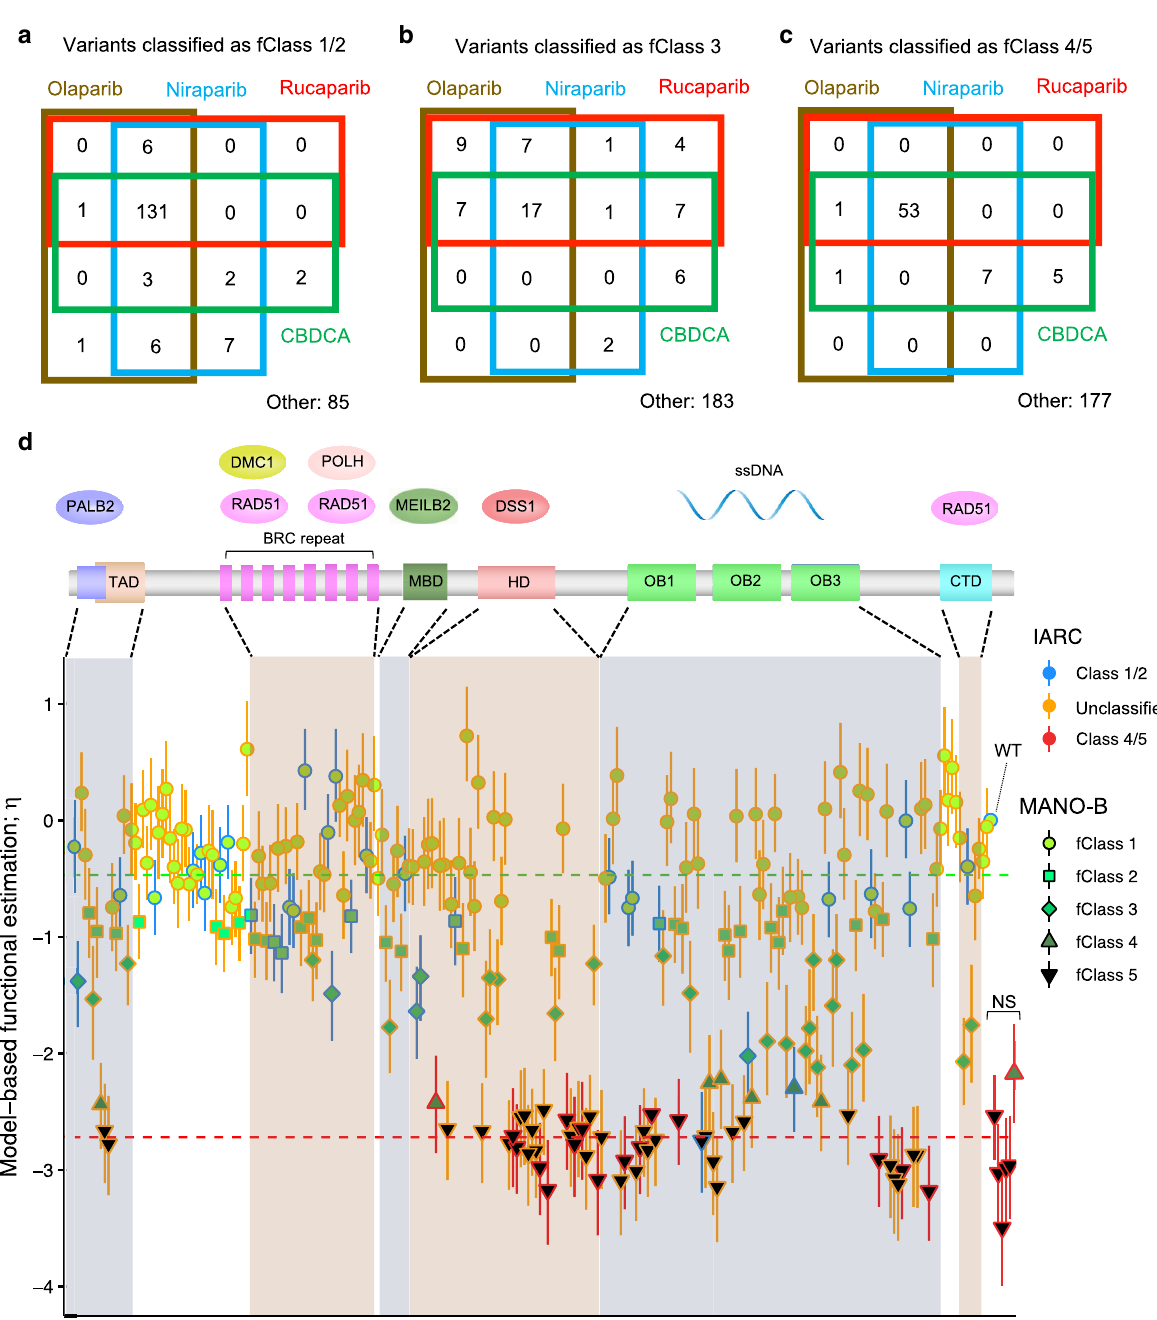
Fig. 3 Evaluation of 244 BRCA2 variants by applying Bayesian inference to the MANO-B method. a – c Functional classi fi cation by the MANO-B method with four drugs. A total of 244 BRCA2 variants were classi fi ed by Bayesian inference. The number of variants classi fi ed for each drug as fClass 1/2 ( a ), fClass 3 ( b ), and fClass 4/5 ( c ) is shown. No variant was classi fi ed as fClass 1/2 with one drug and fClass 4/5 with another drug. d Bar plots of functional variant effects and functional diagnosis of 244 BRCA2 variants mapped against the BRCA2 full-length sequence and domains. The key domains of BRCA2 consist of a PALB2 interaction domain encompassing amino acids (a.a.) 10 – 40, a transactivation domain (TAD) encompassing a.a. 18 – 105, a RAD51- binding domain including eight BRC repeats encompassing a.a. 1008 – 2082, an MEILB2-binding domain (MBD) encompassing a.a. 2117 – 2339, a DNA- binding domain encompassing a.a. 2402 – 3186 and containing a helical domain (HD) encompassing a.a. 2402 – 2669, oligonucleotide/oligosaccharide- binding domains (OBs) (OB) encompassing a.a. 2670 – 2803, 2809 – 3048, and 3056 – 3102, and a C-terminal RAD51-binding domain (CTD) encompassing a.a. 3270 – 3305. The function of each variant was estimated as a variant-speci fi c effect value, η v , based on a two-component model. Data of niraparib are shown as a representative case. The upper and lower components correspond to normal function and loss-of-function, respectively. The dotted lines indicate the median value of each component. The classi fi cation of each variant based on the Bayes factor (BF) is indicated by the color and shape of the lines and plots, as shown in the legend. Variant functions were classi fi ed into fi ve classes by the MANO-B method: fClass 1 (normal) (BF ≤ 0.003), fClass 2 (likely normal) (0.003 < BF ≤ 0.053), fClass 3 (intermediate) (0.053< BF < 18.7), fClass 4 (likely abnormal) (18.7 ≤ BF < 350), and fClass 5 (abnormal) (350 ≤ BF). N = 3 cells were examined over 2 or 3 independent experimental batches. Plots indicate mean values. Open error bars, 95% CIs. WT, wild- type; NS, nonsense